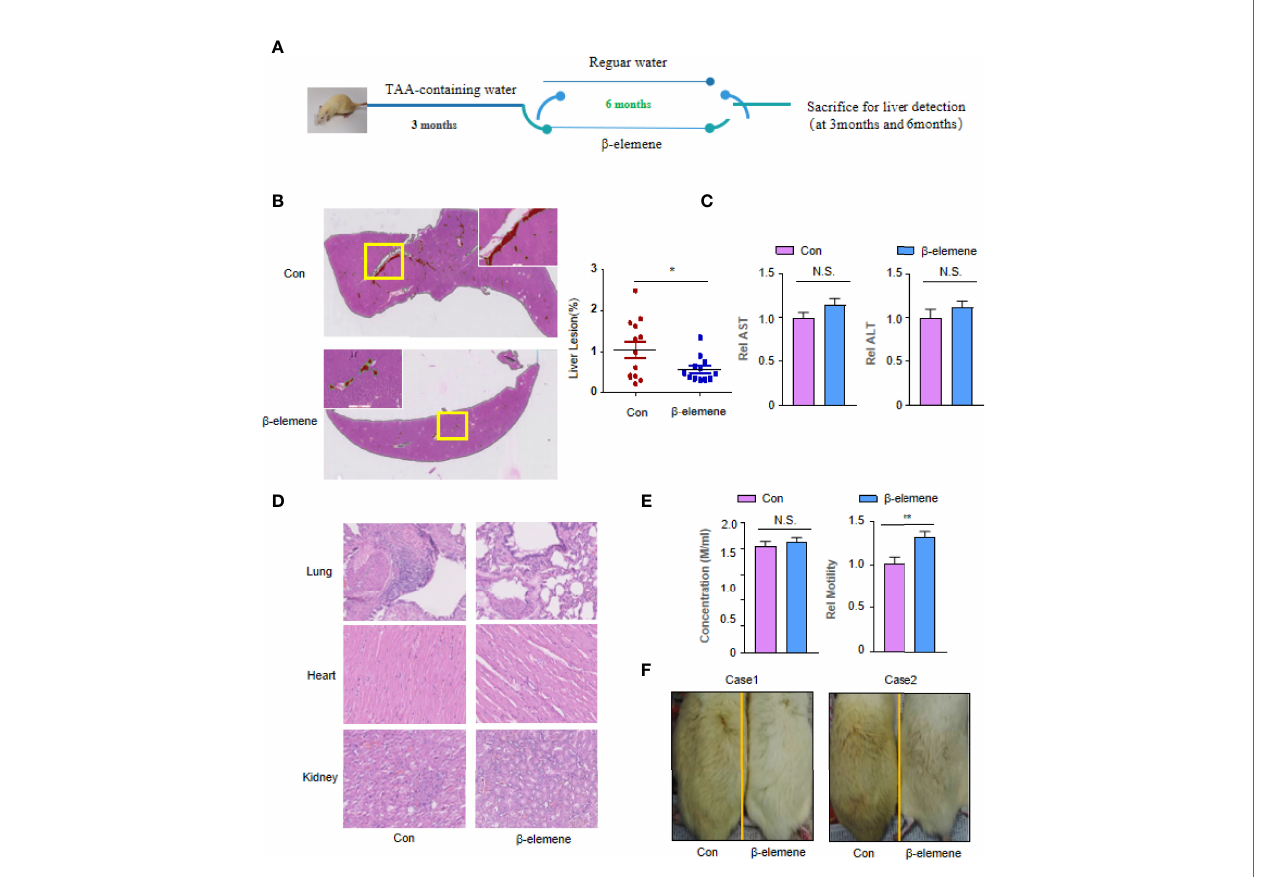
FIGURE 1 | The effectiveness and safety of rats following long-term utilization of b -elemene. (A) Flowchart of the animal experiments. (B) Representative H&E staining image of liver lesions (red) of rats treated with or without b -elemene recognized by deep learning convolutional neural networks (CNNs). The ratio of cholangiolar proliferation lesions recognized by arti fi cial intelligence (AI) was 0.98% ± 0.72% in the control group, signi fi cantly higher than that of the b -elemene (0. 47% ± 0.30%) group ( p = 0.0471). Scale bar, 4 mm. (C) The serum alanine aminotransferase (ALT) and aspartate aminotransferase (AST) levels were measured in indicated mice. (D) No microscopic pathological changes in internal organs including heart, lung, and kidney in the b -elemene group compared with the control group. Scale bar, 800 m m. (E) The sperm motility, not concentration, of rats administered with b -elemene was signi fi cantly higher than that of mice not administered with b -elemene ( p = 0.0033). (F) Aging phenotype assay. The control group was more yellow and shed more hair than the group treated with b -elemene. * p < 0.05; ** p < 0.01; NS, not signi fi